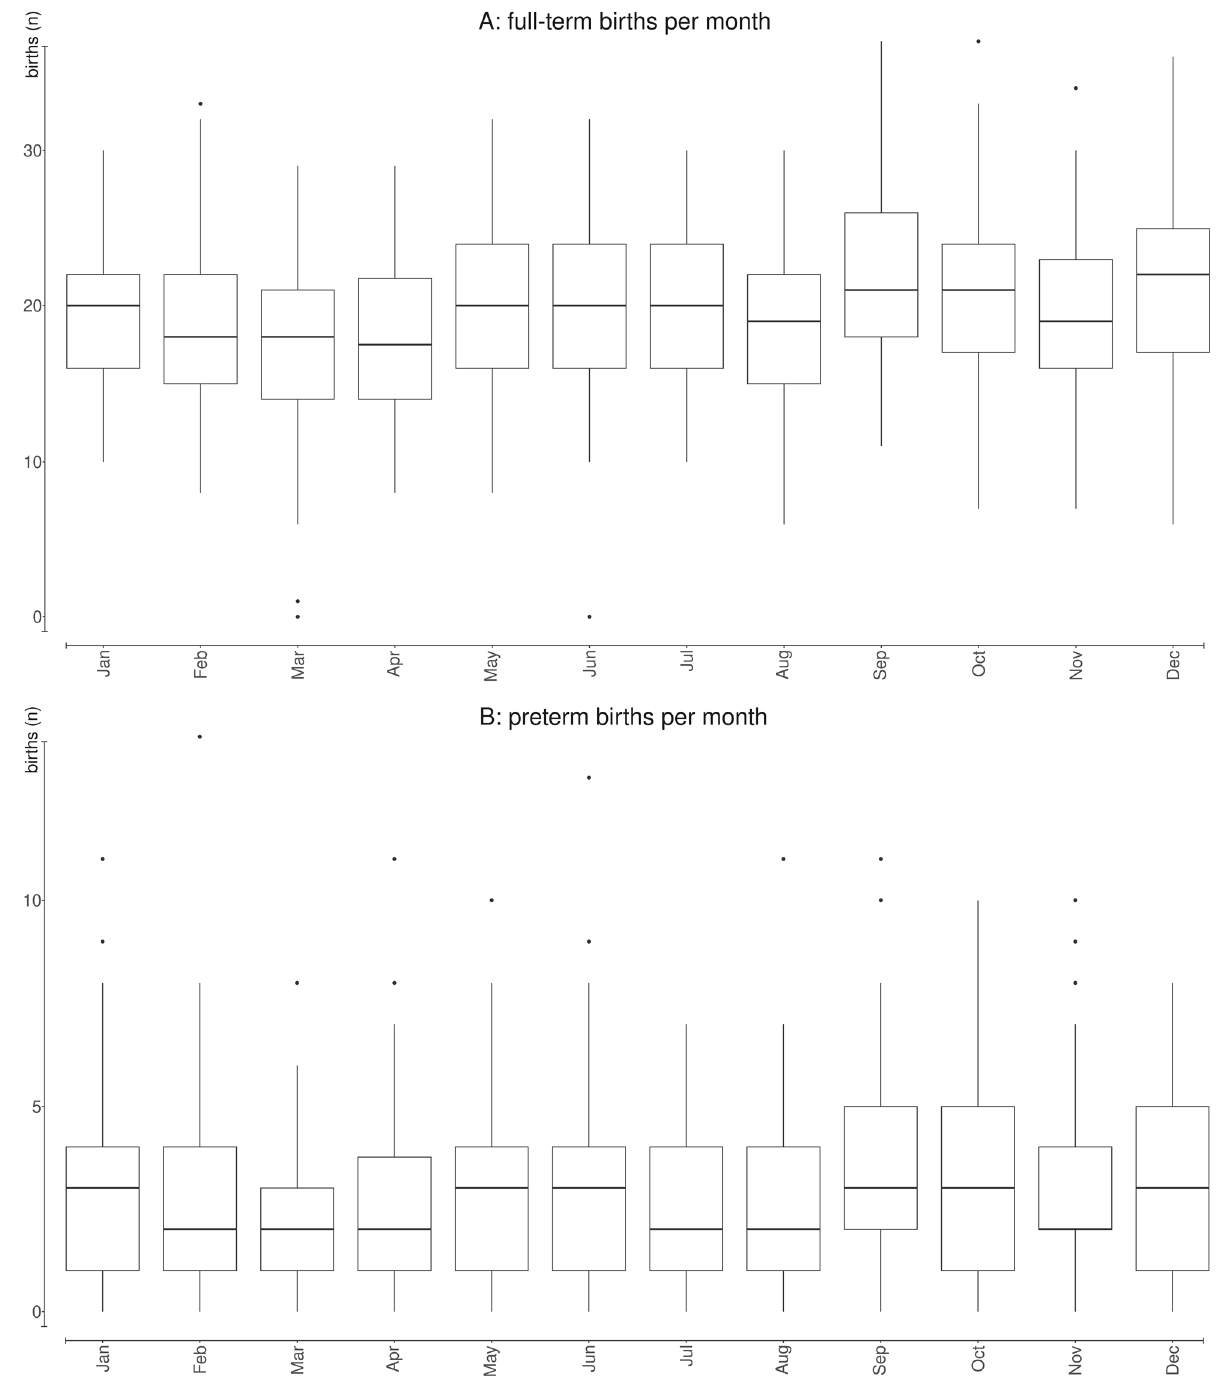
Figure 2. Average number of daily births ( A ) and preterm births ( B ) by month of the year during